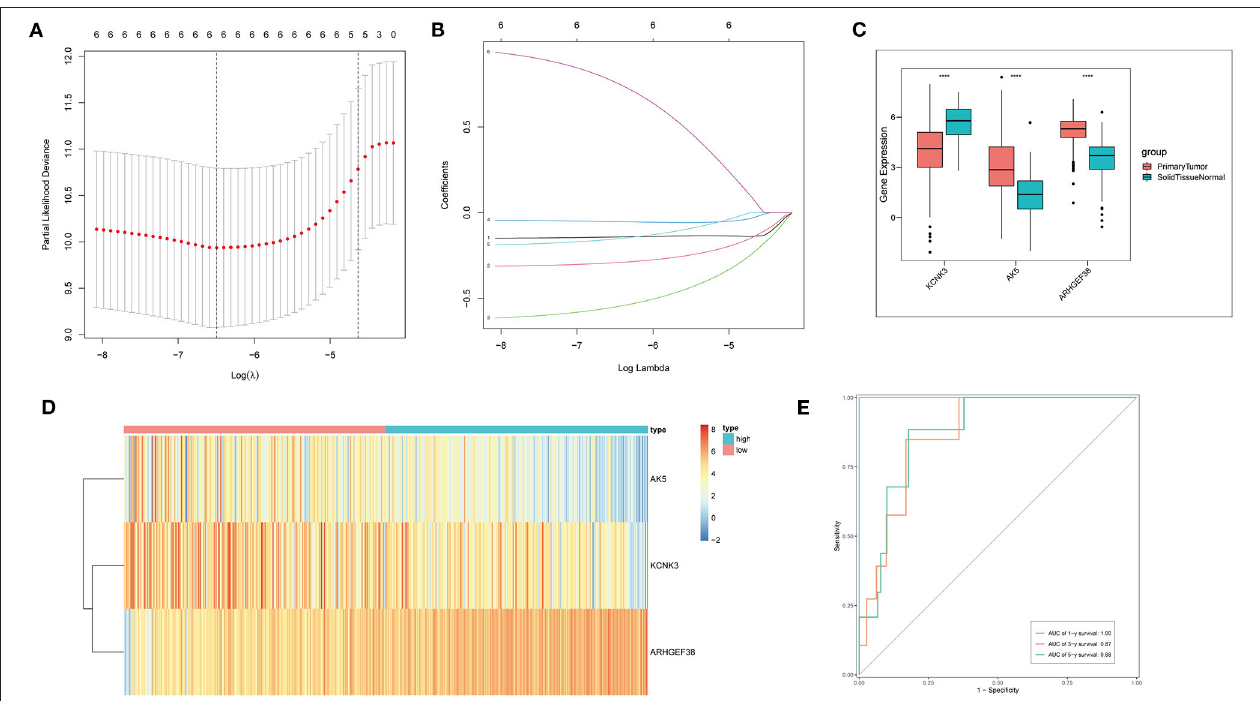
FIGURE 3 | Cox regression and lasso regression analysis. (A,B) Cox regression and Lasso regression were performed to obtain six genes. (C) The relative expression of AK5, KCNK3, and ARHGEF38 in primary tumor and normal solid tissue. (D) The heat map of AK5, KCNK3, and ARHGEF38 expression profiles. (E) Time-dependent ROC